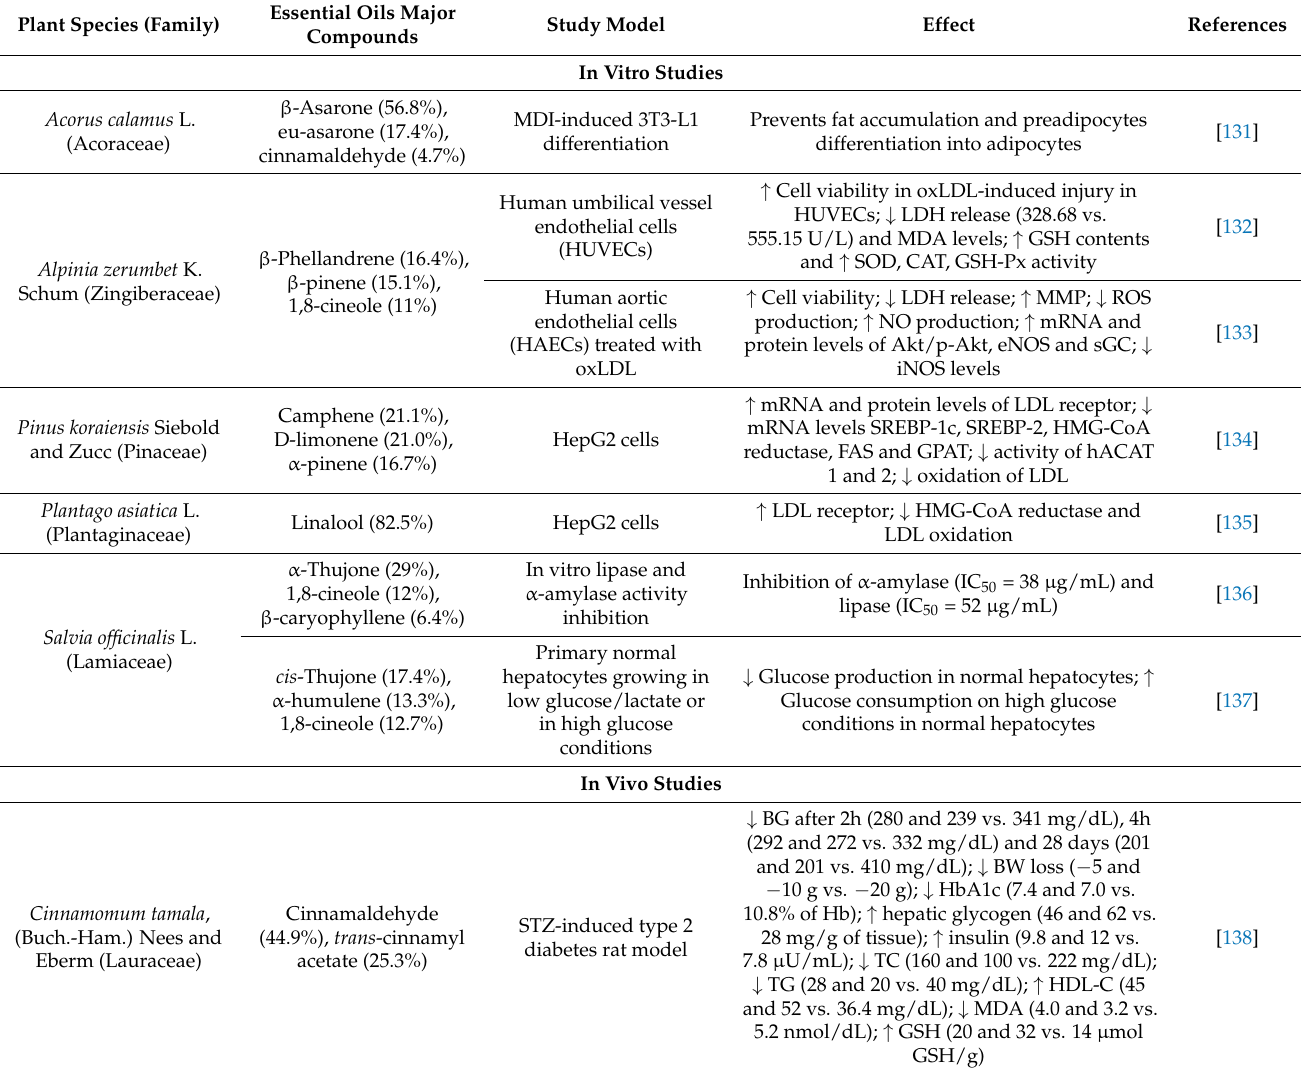
Table 2. Antidiabetic and anti-dyslipidemic essential